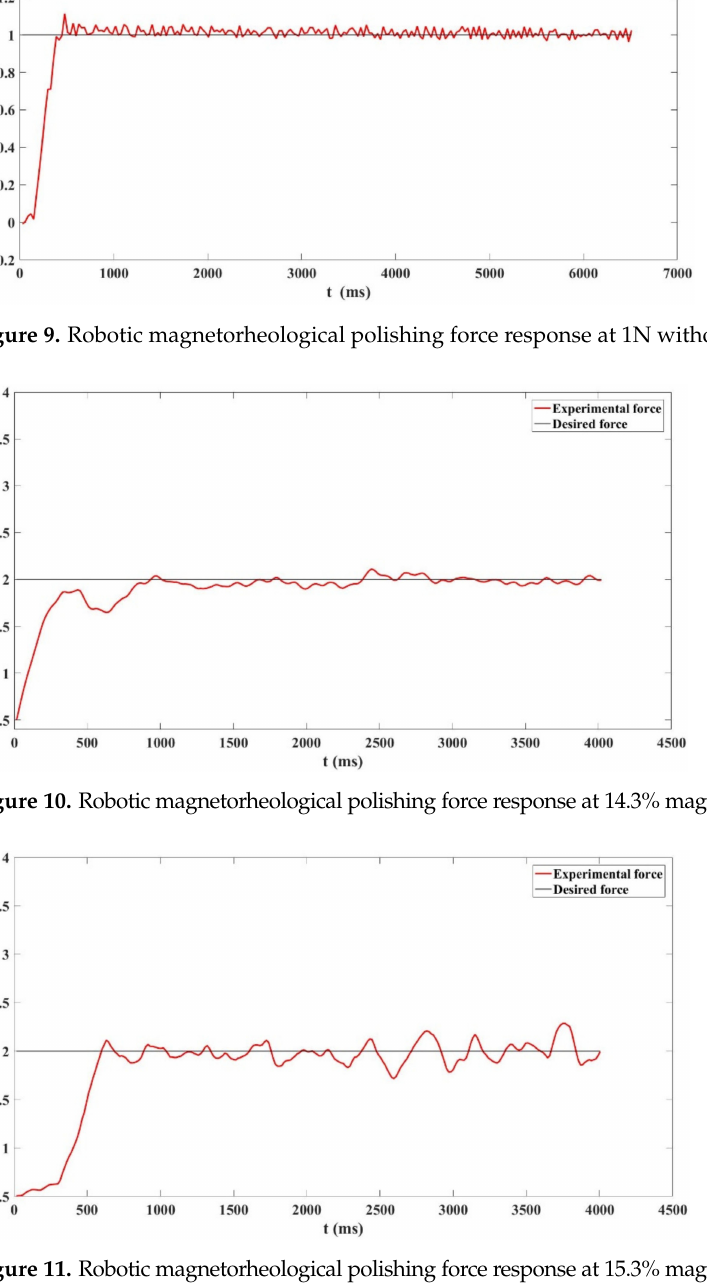
Figure 11. Robotic magnetorheological polishing force response at 15.3% magnetorheological